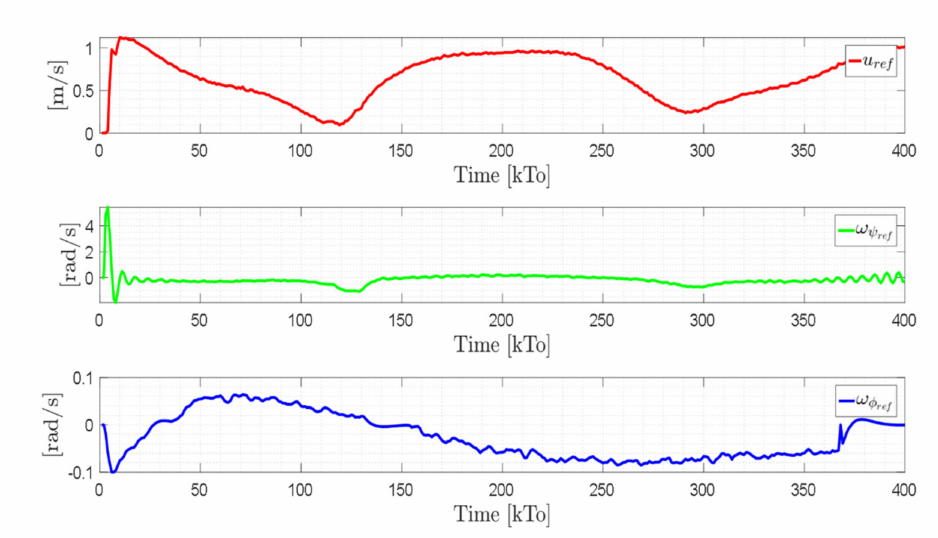
Figure 27. Velocity commands to the standing wheelchair µ ref ( kT 0 ) = ( µ x , ω ψ